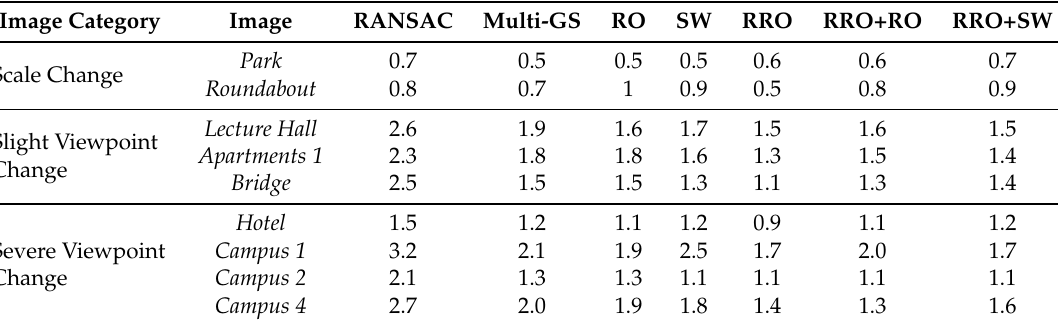
Table 1. The accuracy of fundamental matrix with seven